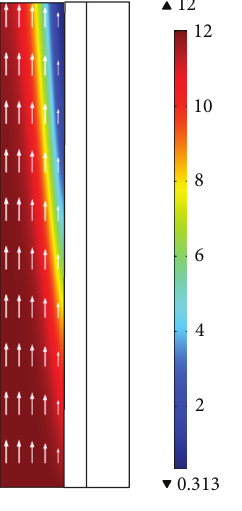
Figure 3: Flux vectors and concentration distributionofMEAin the model. 𝐶 0 = 4 mol m −3 , 𝐶